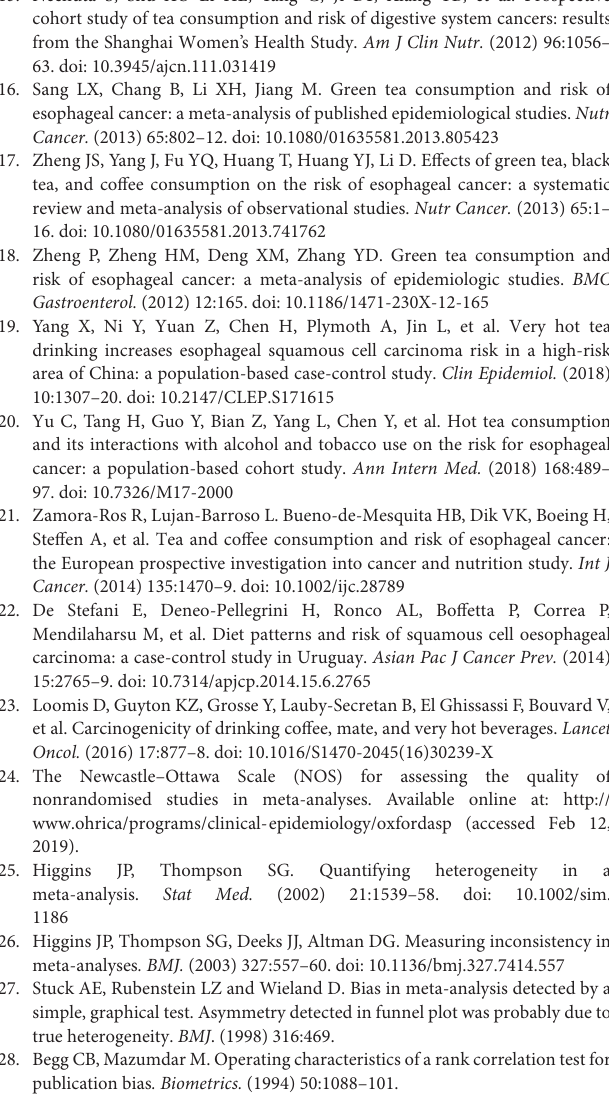
Supplementary Figure 1 | Forest plot of sensitivity analysis by omitting one study in turn. CI, confidence intervals; HB-CC, hospital-based case control studies; PB-CC, population-based case control studies; PS-CH, prospective cohort